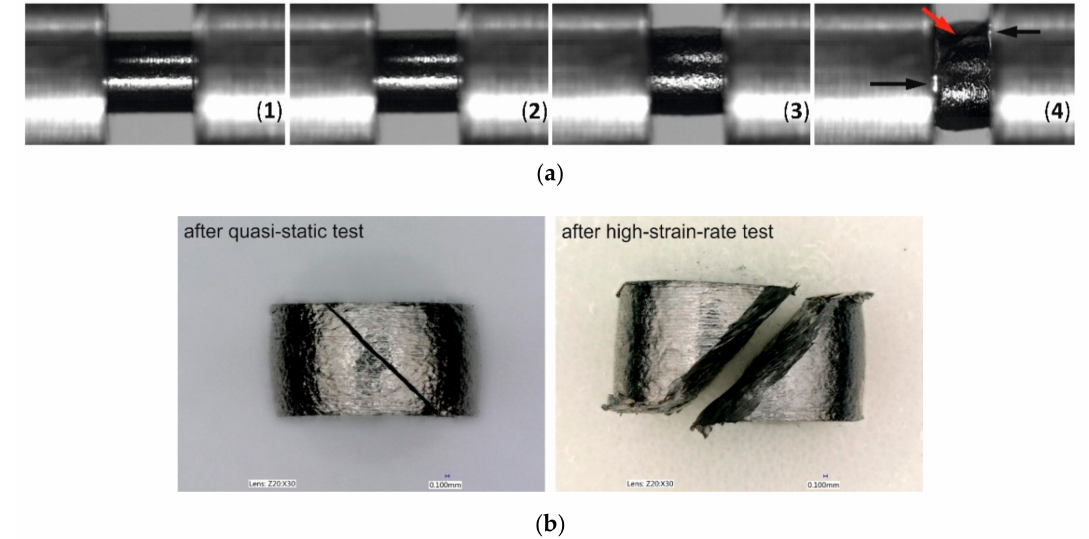
Figure 4. ( a ) High-speed video frames illustrating plastic deformation and fracture of the Ti64BEPM specimen during of the SHPB test at the strain rate of 2100 s − 1 : the start—( 1 ), uniform strain—30 µ s ( 2 ), barreling onset—60 µ s ( 3 ), specimen cracking—120 µ s ( 4 )—arrows indicate: fracture crack—red arrow, and a areas of intensive local heating on the contact surface with the bar—black arrow; ( b ) view of the cracked specimen of Ti64BEPM after quasi-static and high-strain-rate tests in